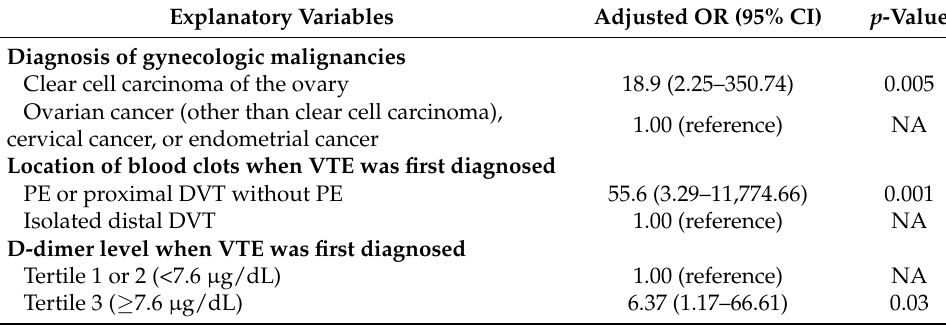
Table 6. Results of the multiple logistic regression